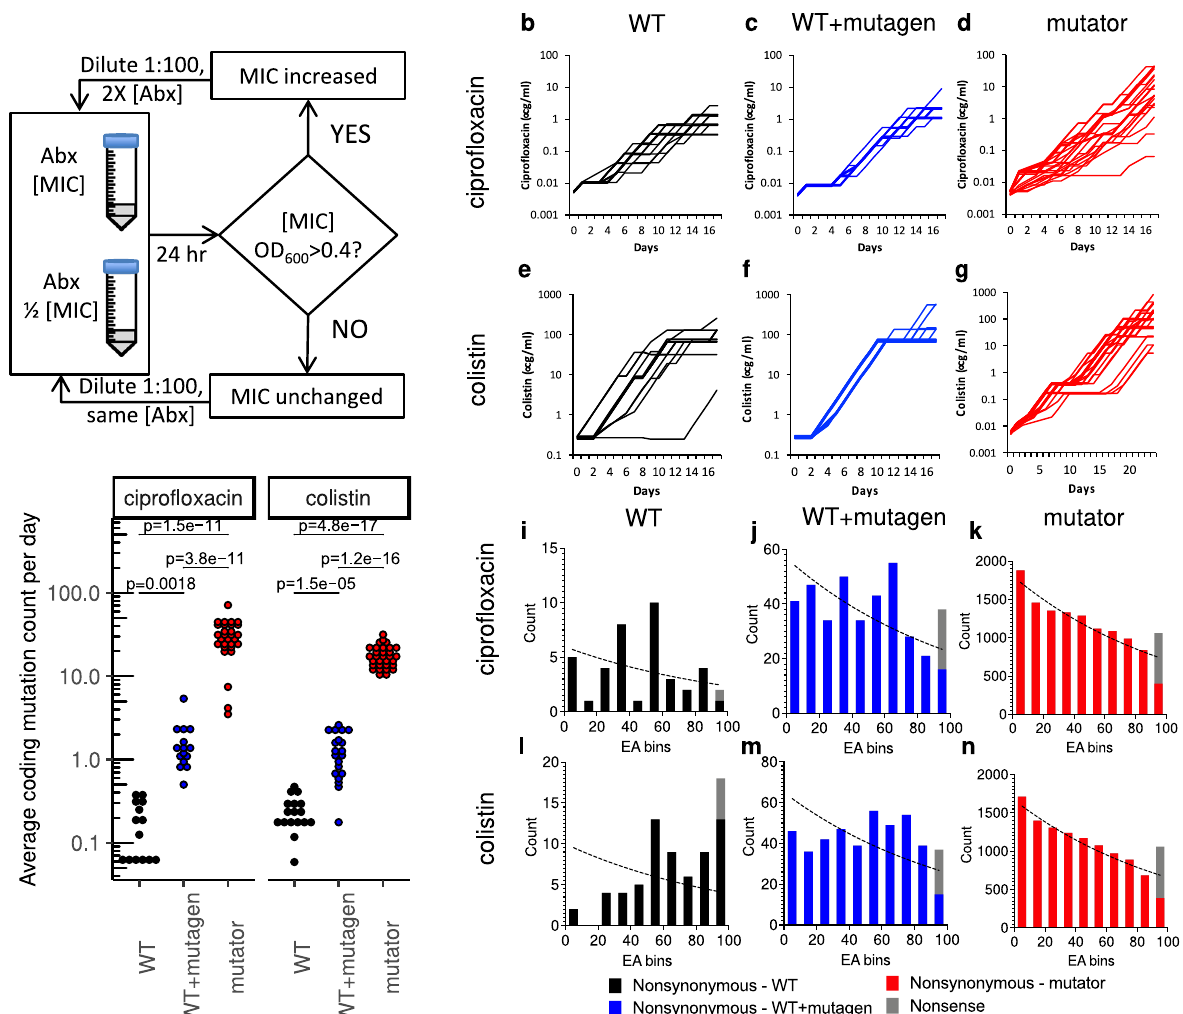
Fig. 1 Experimental evolution. a Flow chart showing how cultures are challenged to grow in minimum inhibitory concentrations (MIC) of an antibiotic (Abx) as determined by a culture optical density at 600 nm (OD 600 ) of greater than 0.4. b – g The change of cipro fl oxacin dosage levels or colistin dosage for the adapting populations over time during the evolution experiment. The populations included ( b ) E. coli MG1655 (WT, black lines) grown in the presence of cipro fl oxacin ( n = 14), ( c ) E. coli MG1655 grown in the presence of nucleotide analogs (WT + mutagen, blue lines) and cipro fl oxacin ( n = 15),